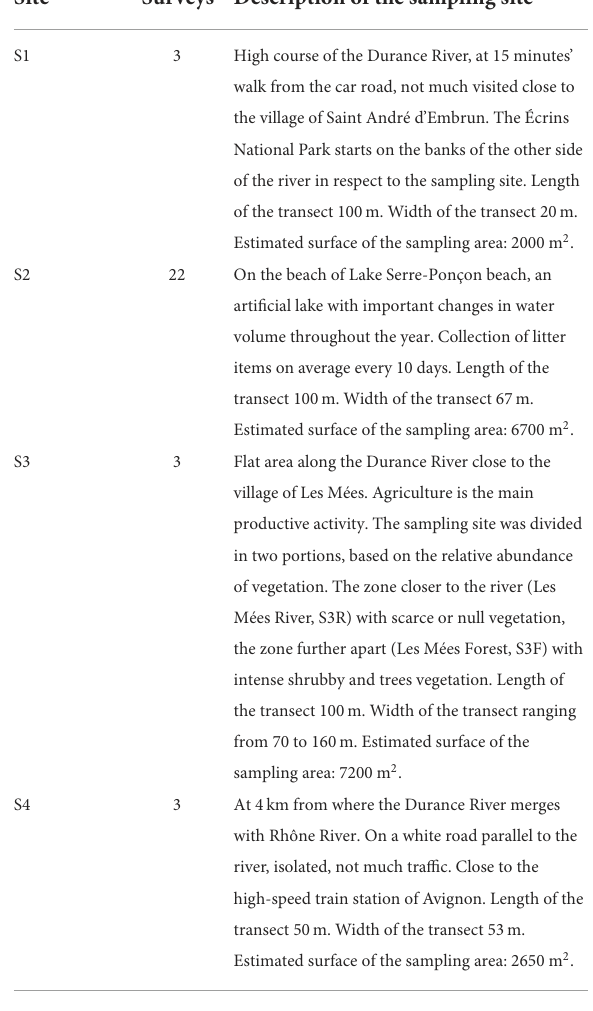
TABLE 1 Survey sites along the Durance River and on Lake Serre-Ponçon, with number of surveys conducted and a description of the